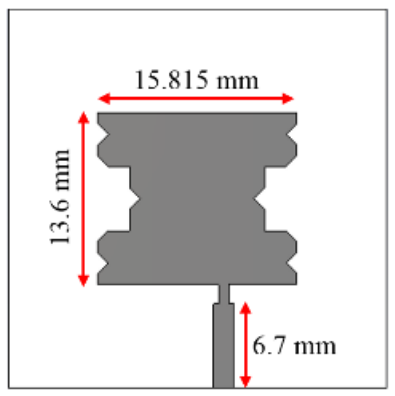
Figure 6. Koch fractal patch antenna. Reprint with permission [4775431338148]; 2020, IEEE. Figure 7a,b illustrate a 5.2 GHz Quasi-Yagi antenna configuration on the substrate of Taconic RF-35 (0.76 mm) to transmit a total power of 3 W, being used as a wireless power transmitter and its specification.